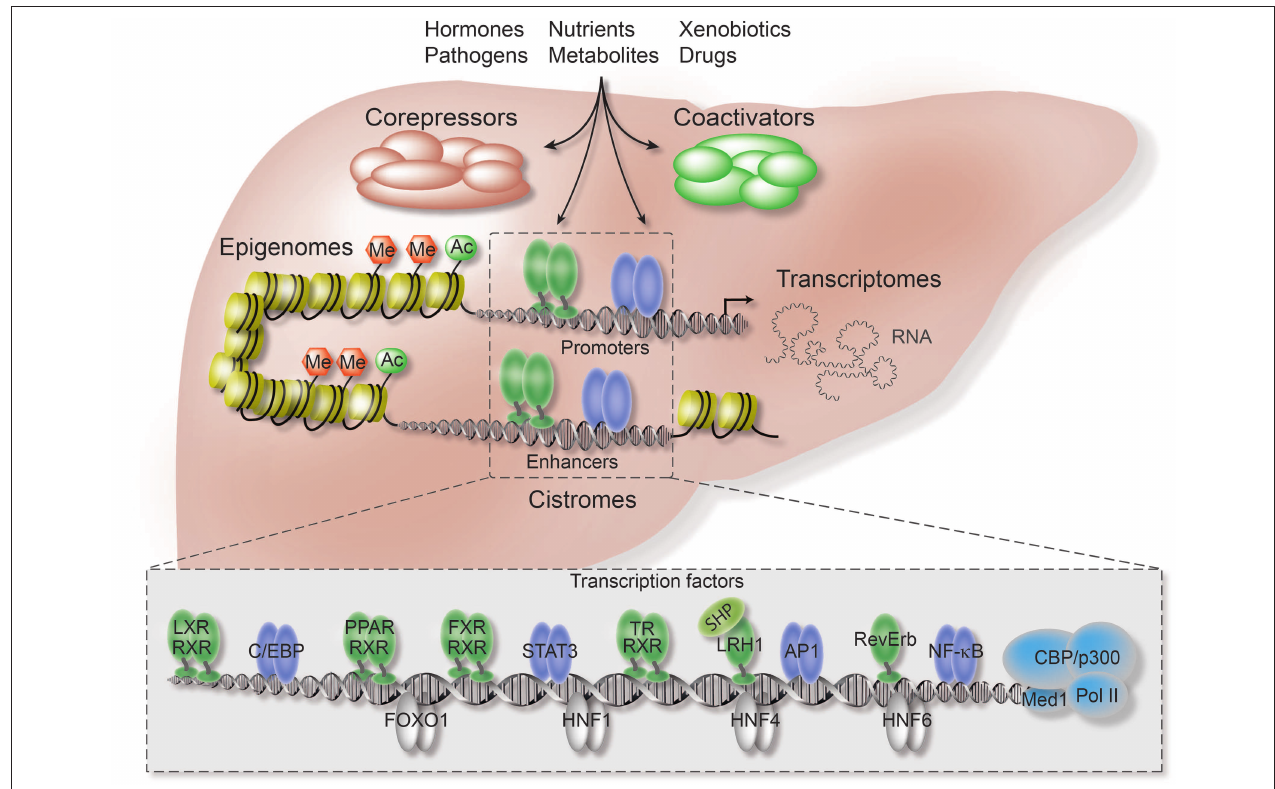
FIGURE 1 | Co-repressors are integral components of regulatory transcriptional networks in hepatocytes. Highlighted are the key components of hepatocyte networks which directly or indirectly interact with co-repressors. Co-repressors are recruited to cis-regulatory chromatin elements, enhancers and promoters, by different classes of TFs, including metabolic NRs ( in green ), inflammatory TFs ( in purple ), and hepatocyte lineage-determining TFs ( in gray ). Both TFs and co-repressors respond to multiple activating and repressing extracellular signals and thereby transform signaling inputs into changes in gene expression and physiological pathways. Co-regulators function within multi-protein complexes that carry enzymatic activities entirely responsible for the sum of PTMs, including (de-)acetylation (Ac) and (de-)methylation (Me), of histones, TFs, and co-regulators. Hepatocyte-specific loss-of-function models, including conditional KO mice, have revealed first insights into the liver functions and target range of co-repressors, including the core subunits of the fundamental NR co-repressor complex. ChIP-seq has been applied to identify hepatocyte cistromes, i.e., the genome-wide binding sites of TFs and co-regulators, as well as epigenomes, i.e., the genome-wide chromatin modifications such as active and repressive histone marks. TFs and co-regulators play distinctive roles in linking cistrome and epigenome to determine the signal-regulated hepatocyte transcriptome, i.e., coding and non-coding RNAs, and thereby gene expression and physiological